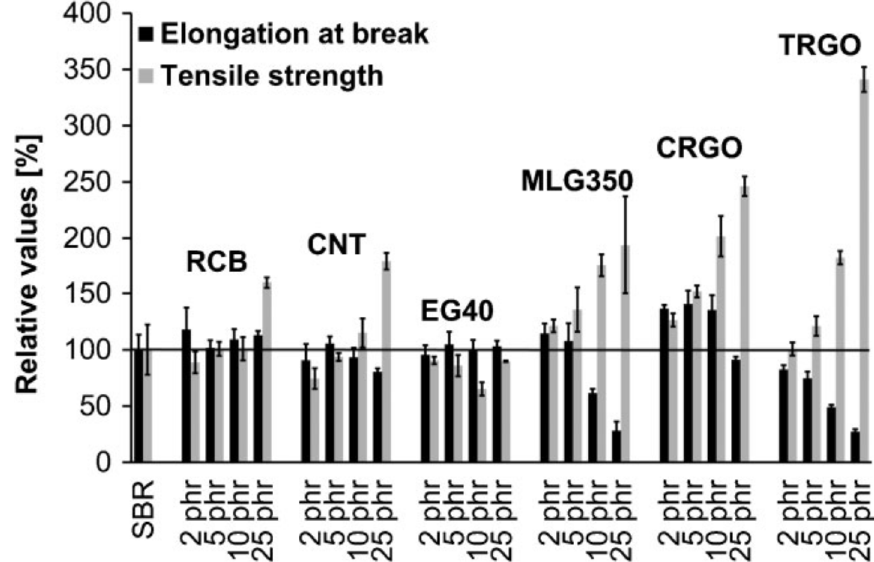
Figure 9. Elongation at break and tensile strength for SBR/C filler composites relative to neat SBR. Reproduced with permission from [79], Copyright Wiley, 2014.